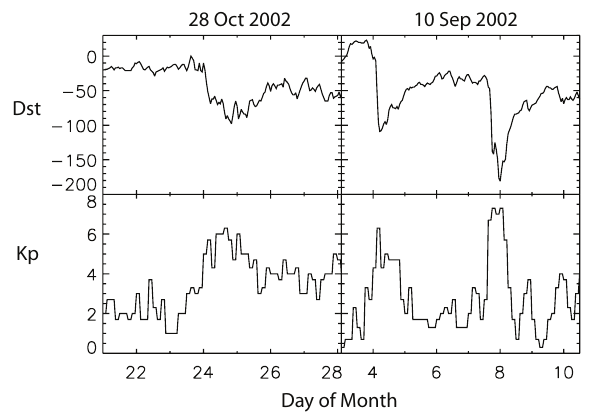
Fig. 15. D st (top) and K p (bottom) versus time for the 28 October 2002 (left) and 10 September 2002 (right) events, with the event time at the right side of each panel.